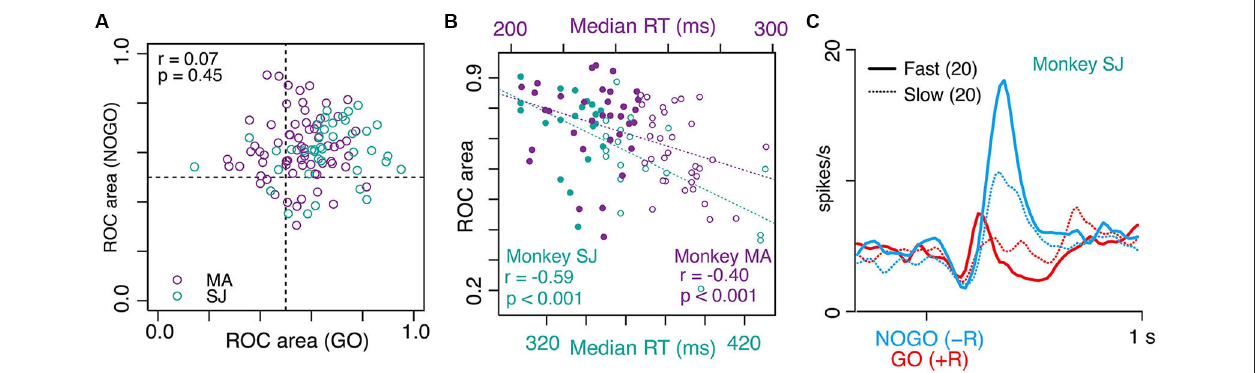
respectively). (B) Correlation between small-reward preference of each neuron (ROC value) and median RTs of GO trials in GO( + R)/NOGO( − R) block. Each data point indicates the ROC value of one neuron’s preference for NOGO( − R) relative to GO( + R) and median RT in the designated block. Filled and open circles indicate fast and slow half-blocks, respectively. (C) Population histogram (smoothed, SD = 20 ms) of LLF neurons